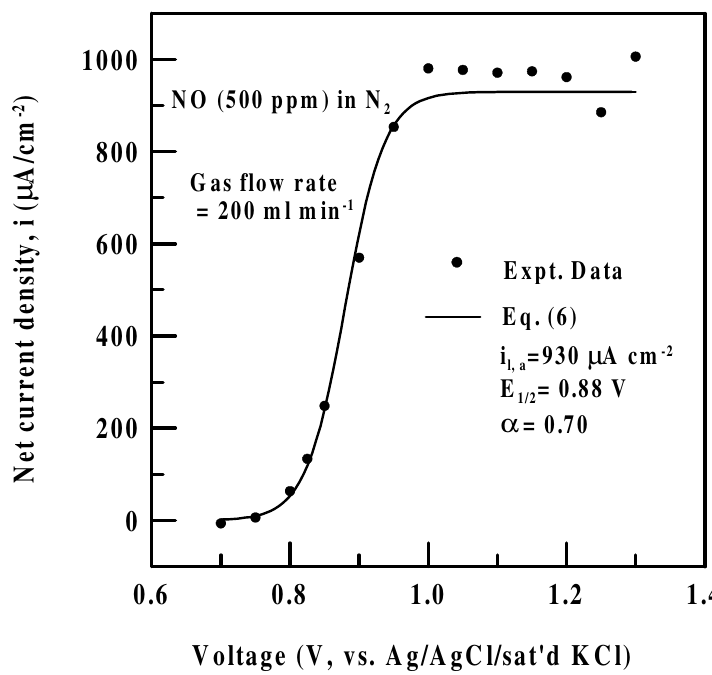
Figure 4 . The net current density-potential (i-E) data for oxidizing 500 ppm NO at a Pt/Nafion (cid:226) electrode. The gas flow rate is maintained at 200 ml/min. The solid curve is obtained by plotting Eq. (6) with appropriate